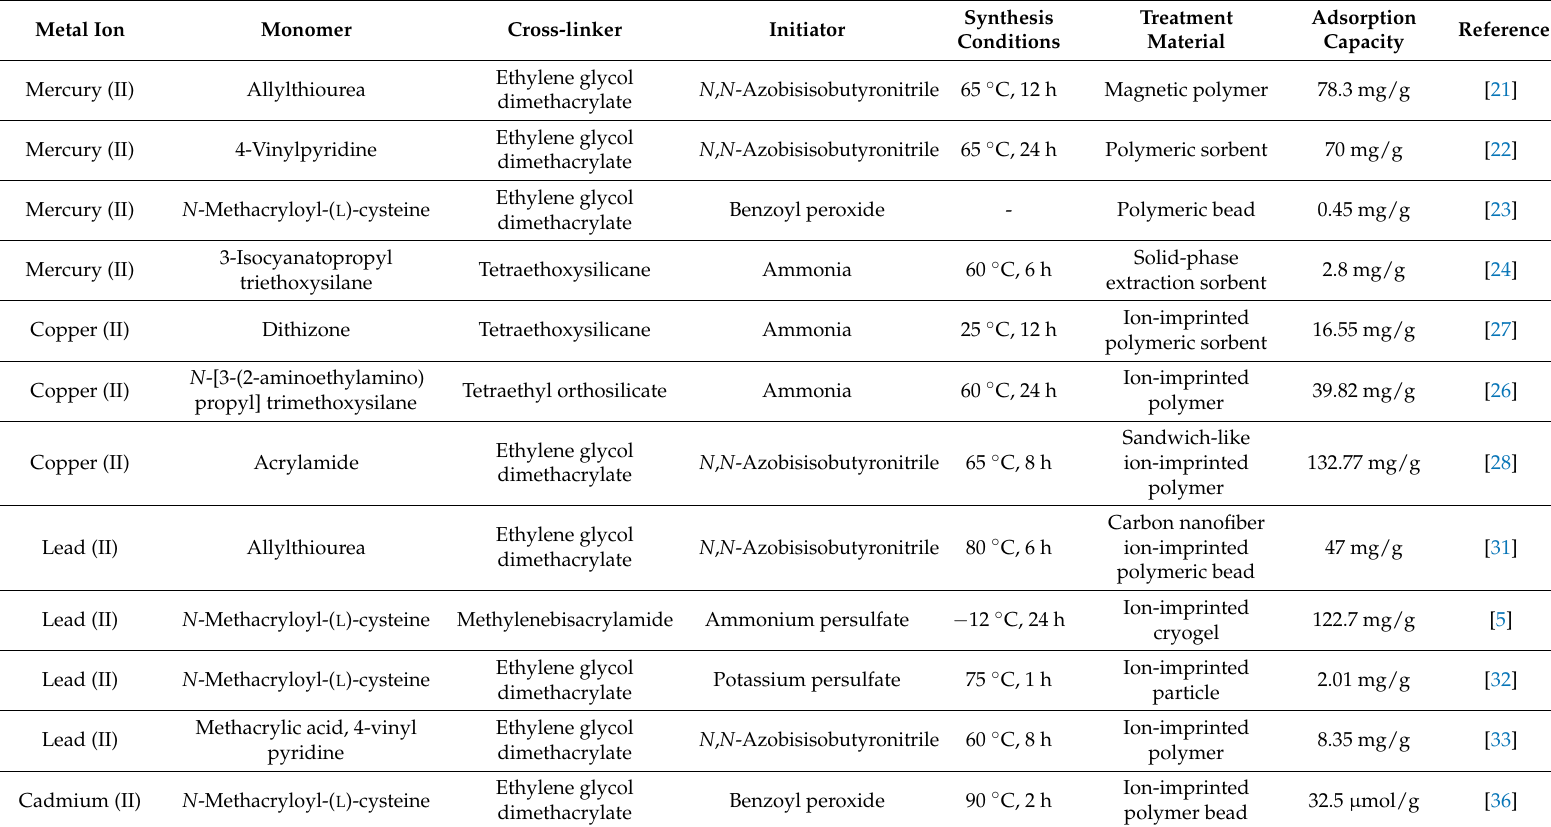
Table 1. Comparison of different studies for meal ion